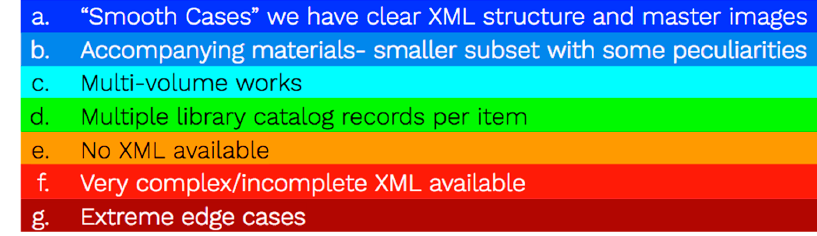
Figure 6. Pages Online migrated from Variations to Fedora 4 in stages.